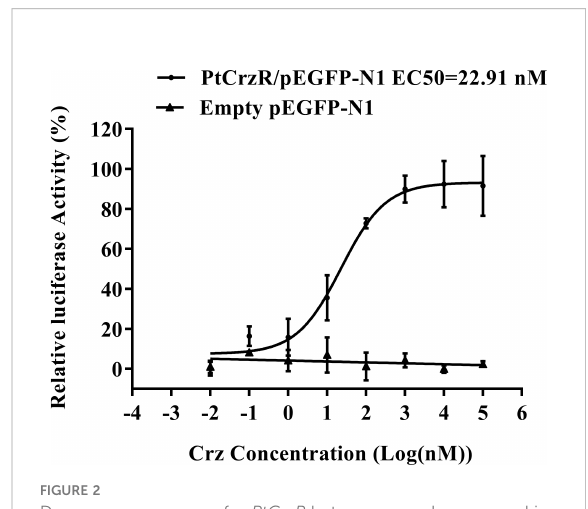
FIGURE 2 Dose-response curves for PtCrzR heterogeneously expressed in HEK293T cells. Different concentrations of PtCrz peptides were treated and the concentration of cAMP was determined. Each data point was a mean value ± SE from three independent biological